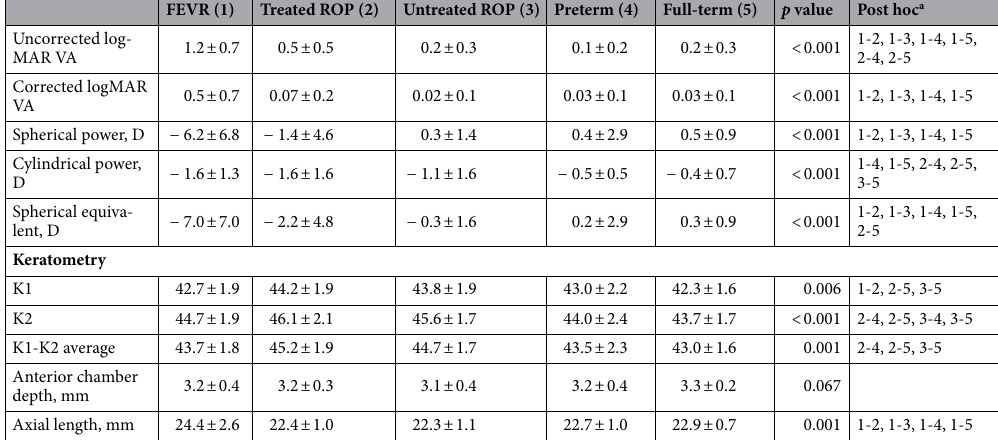
Table 2. Refractive error and optical-component features of patients. FEVR: familial exudative vitreoretinopathy; ROP: retinopathy of prematurity; VA: visual acuity; D: diopters. a Intergroup comparisons were made using the post hoc comparisons from significant generalized estimating equations; the pairs of groups listed (e.g., 1-2) are significantly different. Pairs not shown are not significantly different.